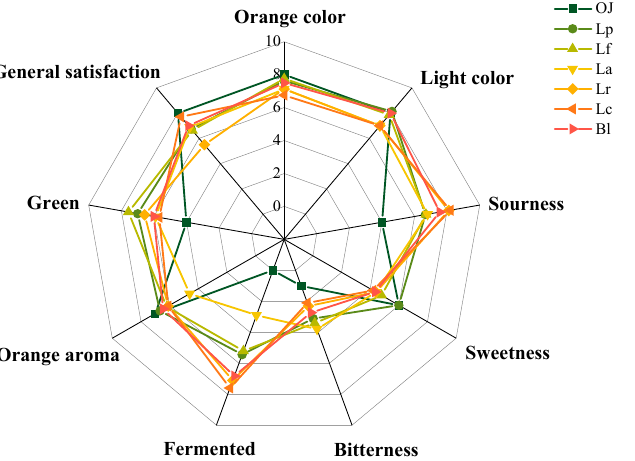
Figure 6. Sensory radar for the mean values of the sensory attributes of the orange juices fermented by Lactiplantibacillus plantarum (Lp), L. fermentum (Lf), L. acidophilus (La), L. rhamnosus (Lr), L. paracasei (Lc), Bifidobacterium longum (Bl) and control ( n = 3). Control (OJ) was original orange juice.